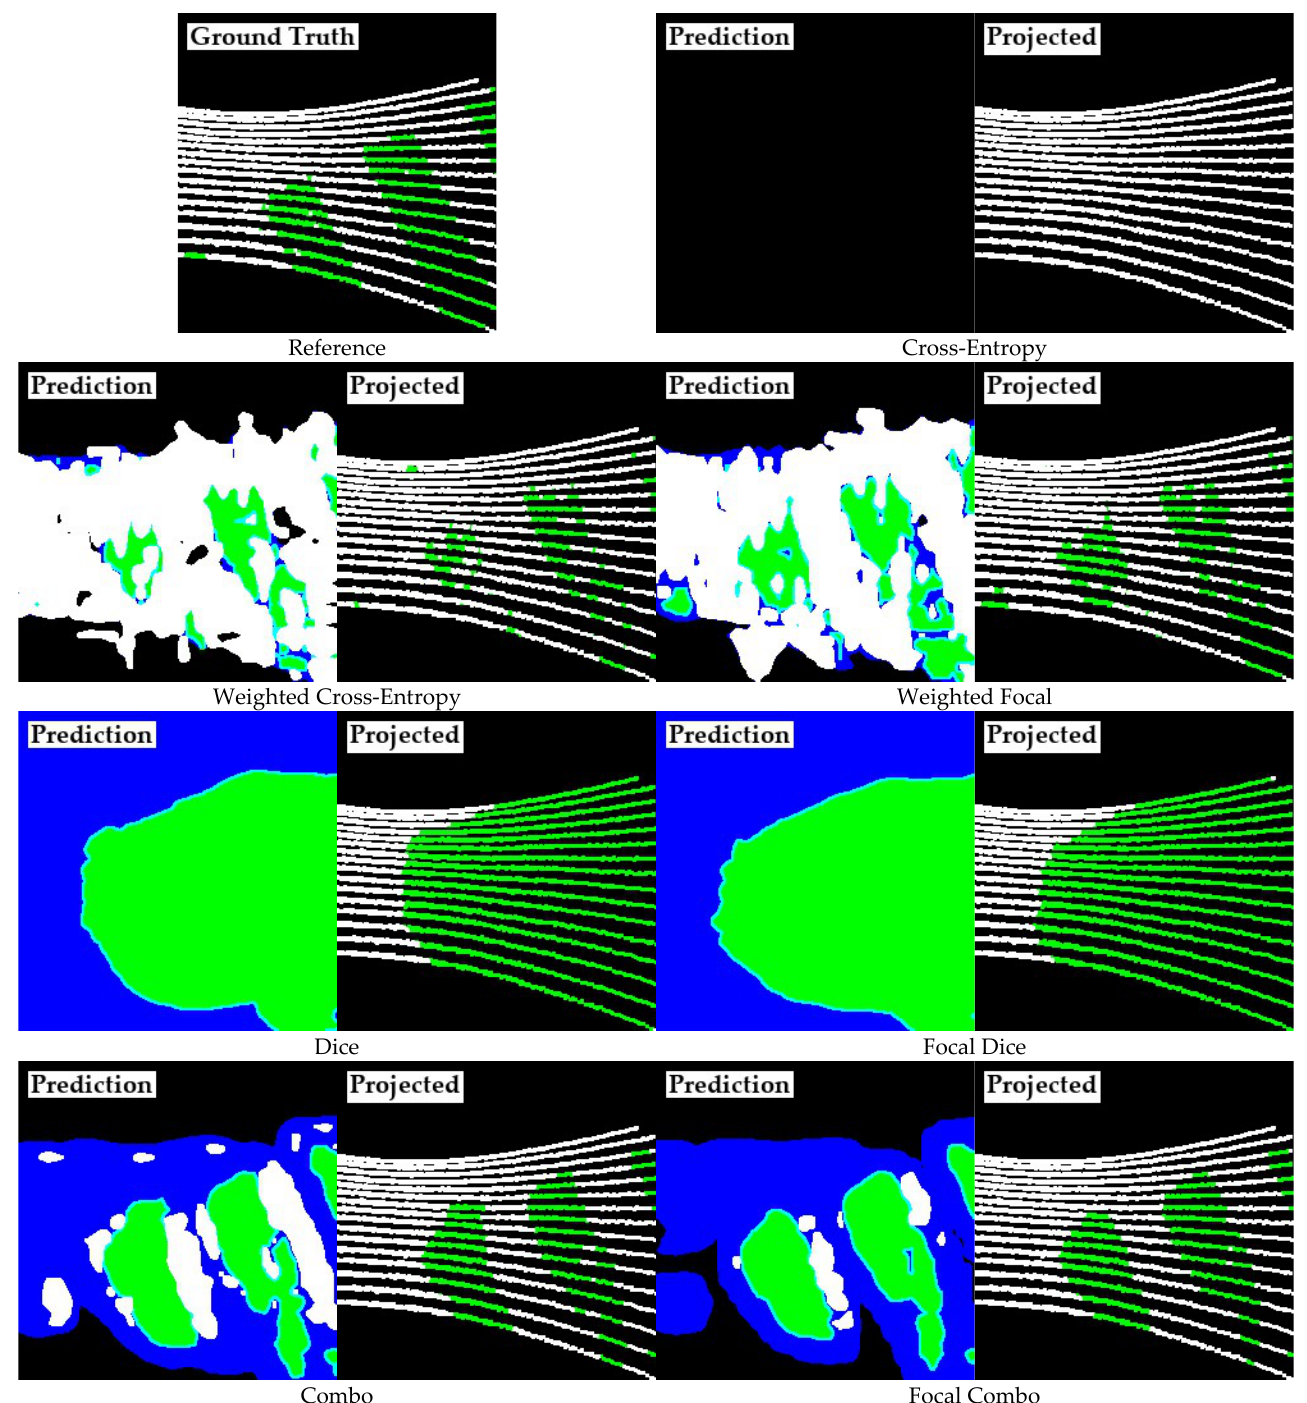
Figure 9. Sample prediction results and projected counterparts using